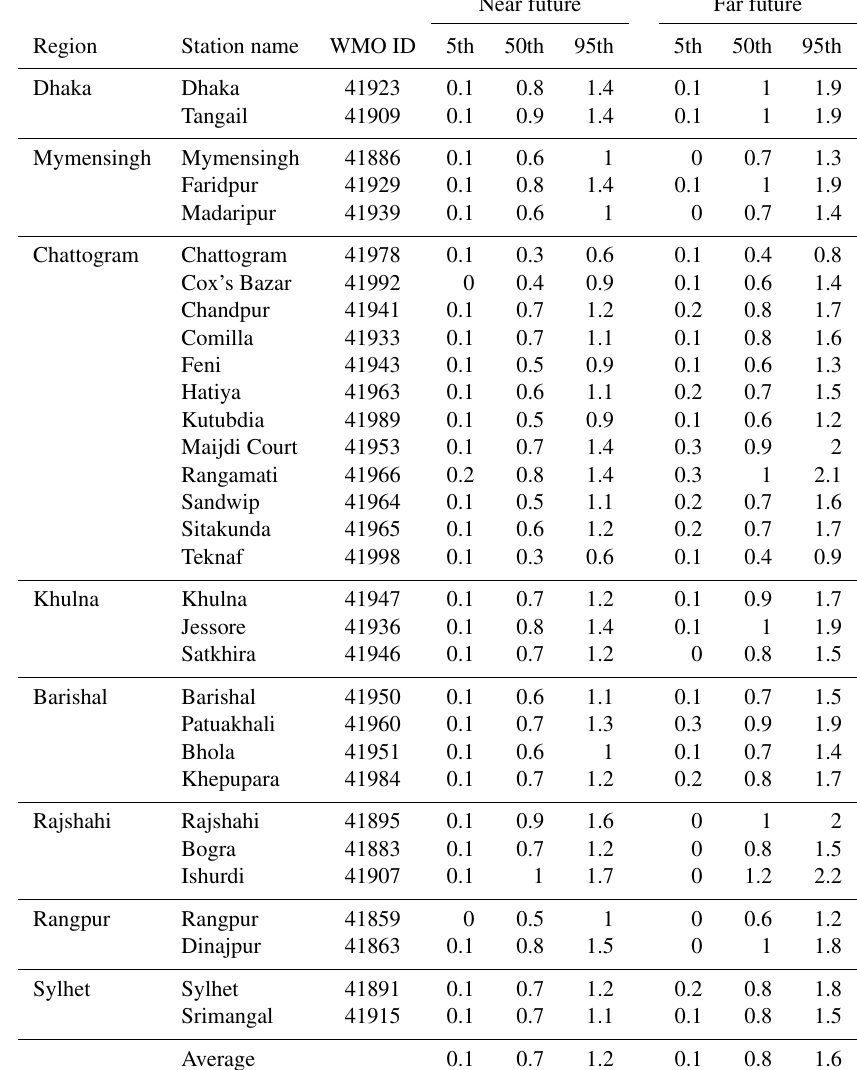
Table 2. The 5th, 50th and 95th percentile values of projected changes in maximum temperature (unit: ◦ C) in Bangladesh for the near future (2021–2050) and far future (2071–2100) relative to the 1981–2010 period for